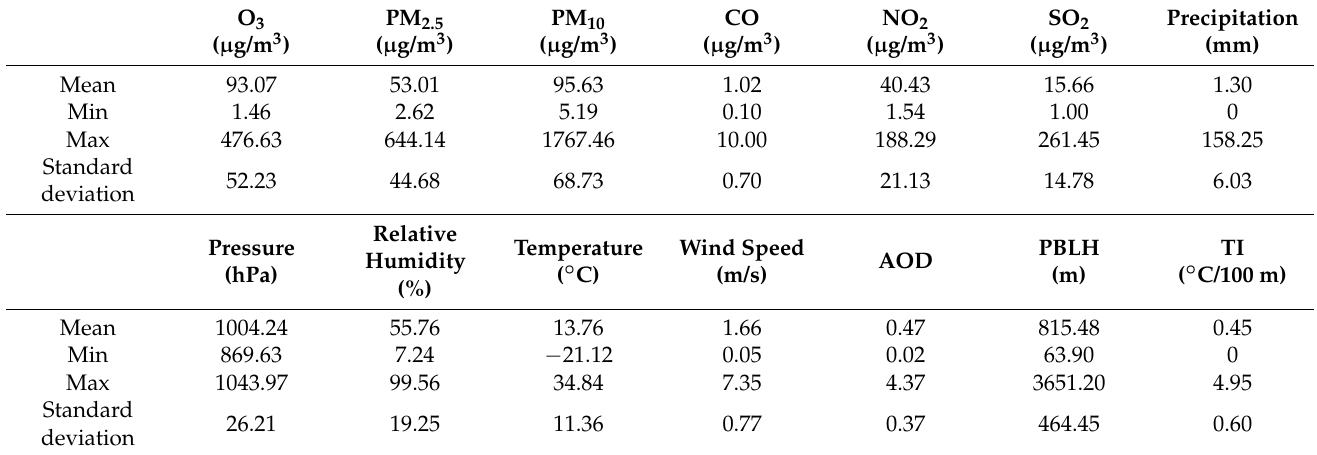
Table 2. Descriptive statistics of daily values for the predictor variables from 2017 to